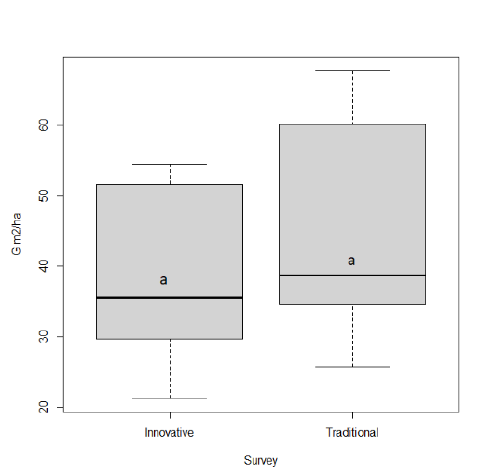
Figure 6 Boxplot of basal area (G, m 2 /ha) computed for each plot by traditional and innovative survey. Boxes with different letters indicate a statistically significant difference (p<0.05).